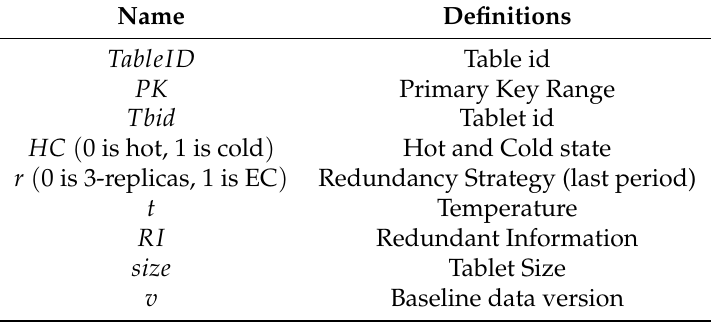
Algorithm 1: Hot and cold tablets recognition